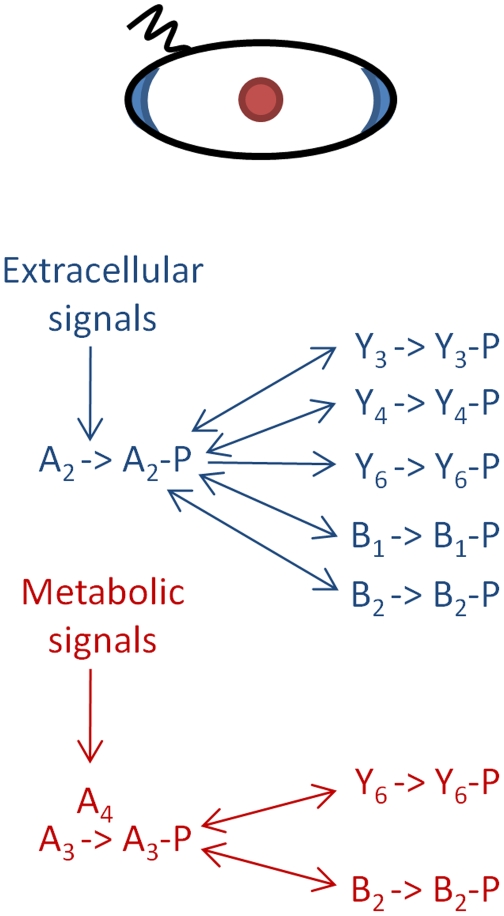
Diagram showing the RRs phosphorylated by the polar (blue) and cytoplasmic (red) chemotaxis clusters.The polar chemotaxis cluster contains CheA2 and responds to the external environment. CheA2 autophosphorylates and can then serve as a phosphodonor for all of the RRs. The cytoplasmic chemotaxis cluster contains CheA3 and CheA4, and is thought to respond to the metabolic state of the cell. CheA3 is phosphorylated by CheA4. Unlike CheA2-P, CheA3-P is not able to phosphorylate all of the RRs – it can only phosphorylate CheY6 and CheB2. All of the RR-Ps spontaneously autodephosphorylate; however, the dephosphorylation of CheY6-P is accelerated by the phosphatase activity of CheA3.